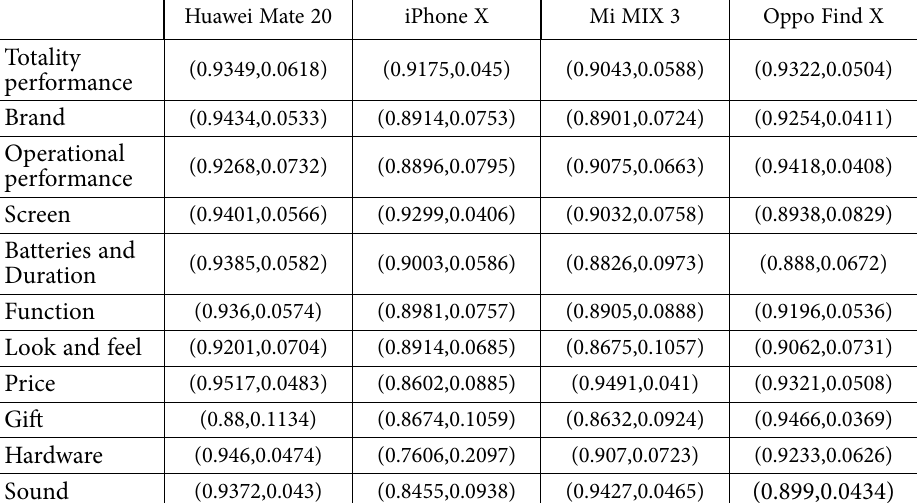
Table 12. The integrated intuitionistic fuzzy decision